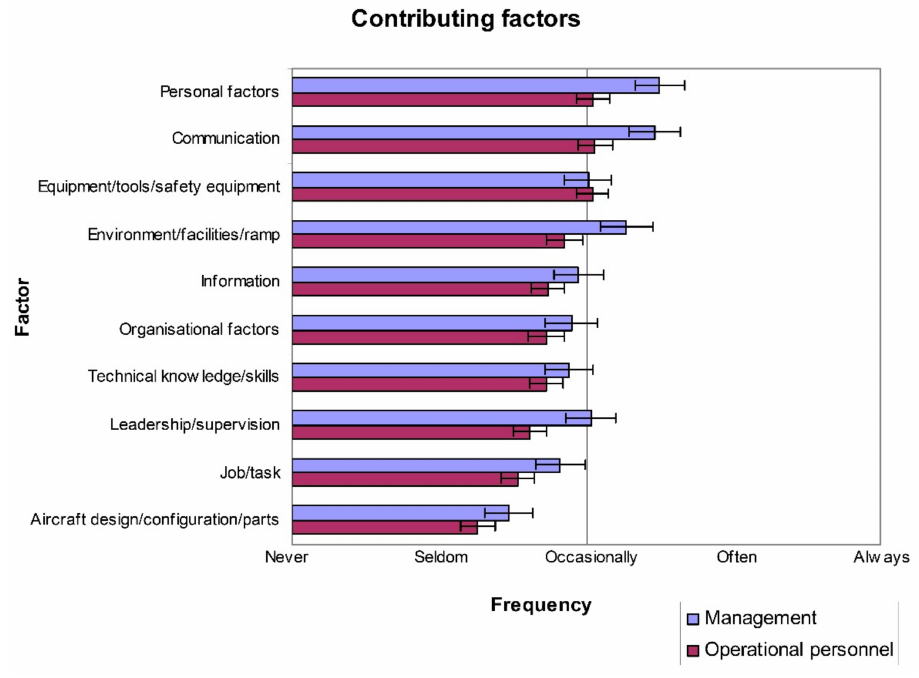
Figure 4. The most frequent causal factors involved in mistakes on the ramp